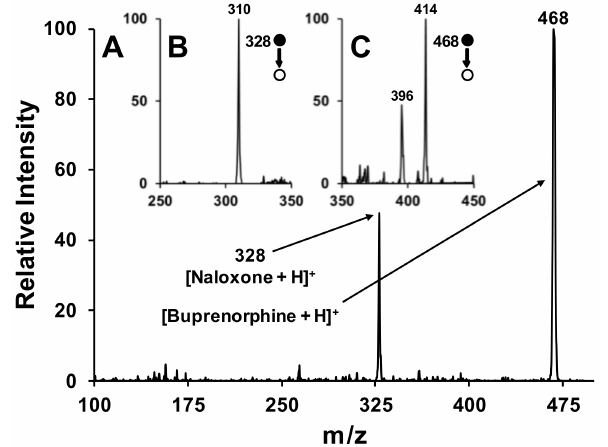
Figure 5. ( A ) PCSI-MS spectrum collected directly from Suboxone ® sublingual film, a prescribed treatment for opioid addiction. Addition of the film to the conical volume of the source and spray solvent produces intense ion signatures for protonated naloxone ( m / z 328) and protonated buprenorphine ( m / z